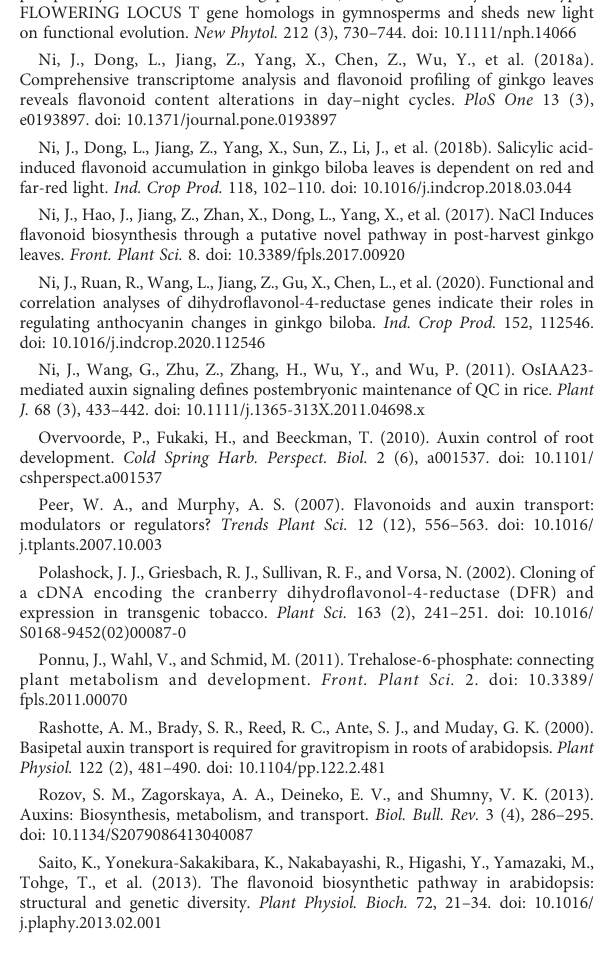
SUPPLEMENTARY TABLE 1 Primers used for quantitative reverse transcription polymerase chain reaction.